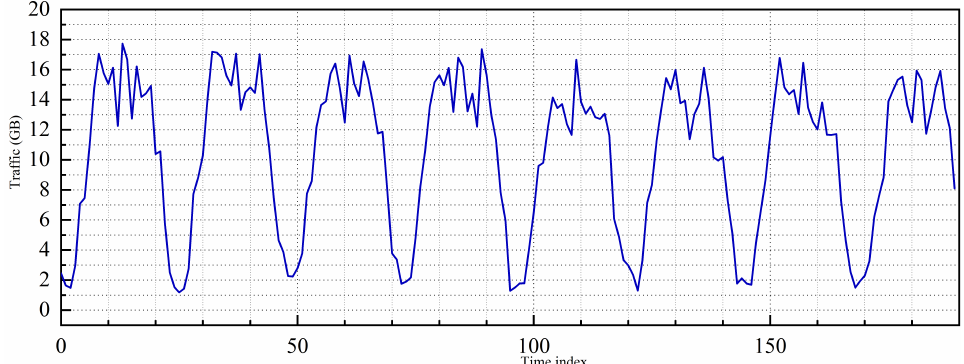
Figure 7. BS-level downlink traffic.